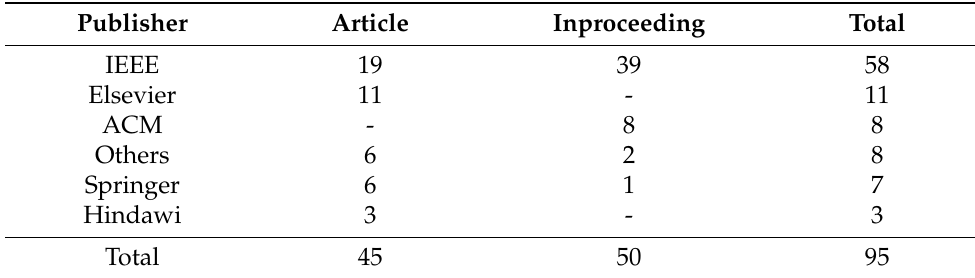
Table 1. Publications by type and